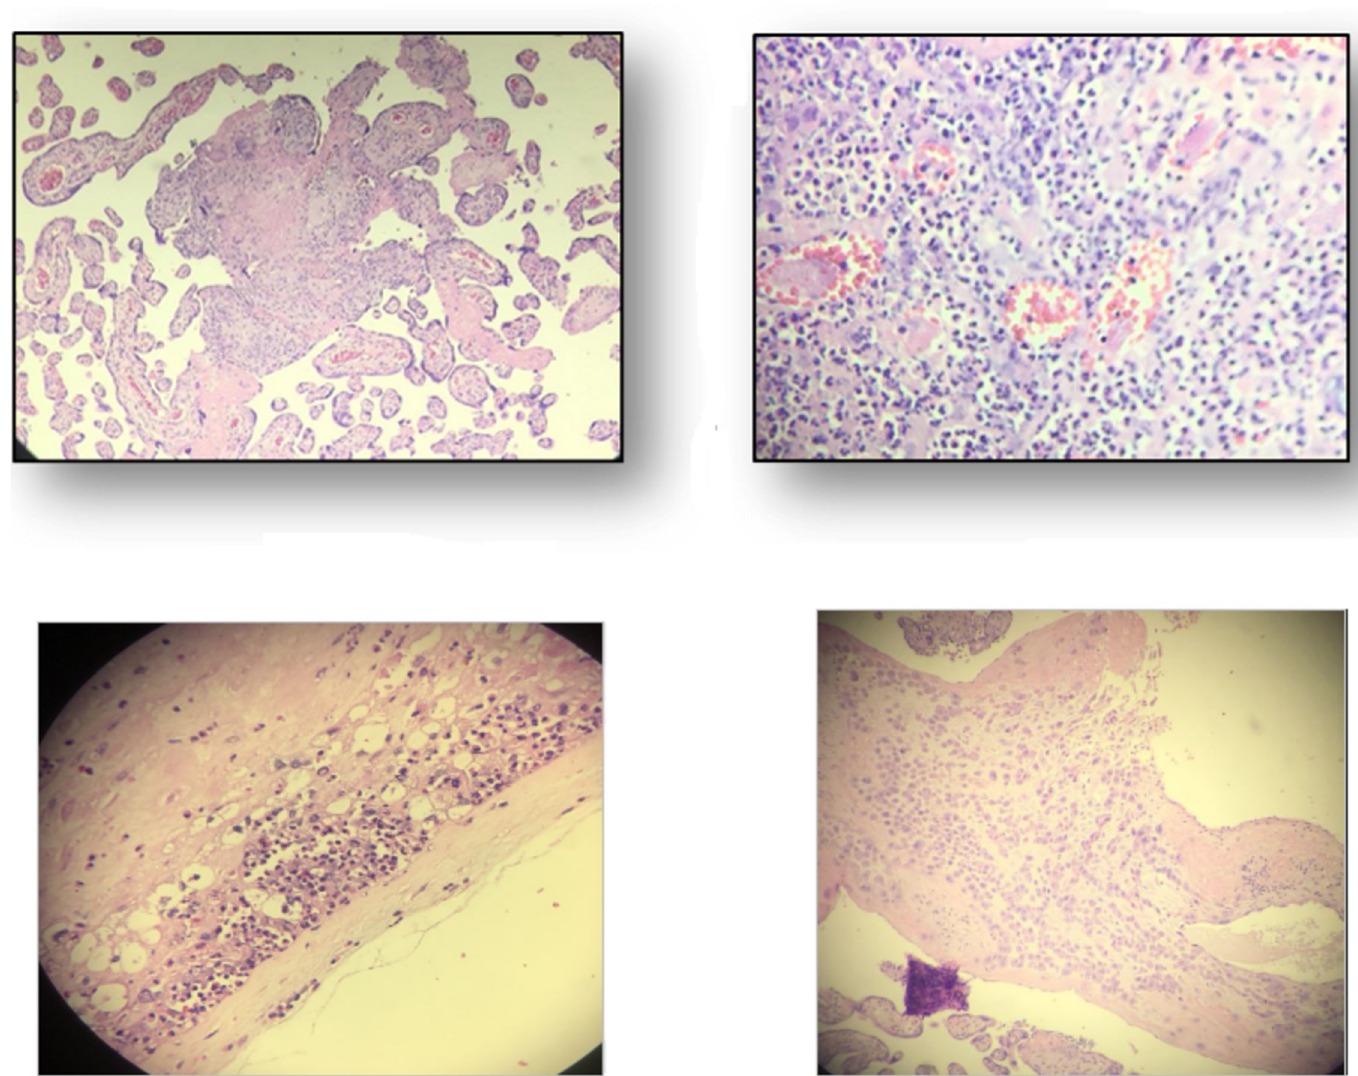
Fig 4. Photomicrography of the placental samples immunostained with anti-ZIKV MAb and stained with Harris’s hematoxylin (squares). (A) Case 1. Placenta sample (chorion frondosum) showing placental hypoplasia, accelerated villous maturation and chronic villitis (TORCH-like). (B) Case 2—Placenta sample showing accelerated villous maturation and corangiosis. (C) Case 3—Placenta sample showing accelerated villous maturation and acute chorioamninonitis. (D) Case 4- Placenta sample showing accelerated villous maturation and fibrin deposition.